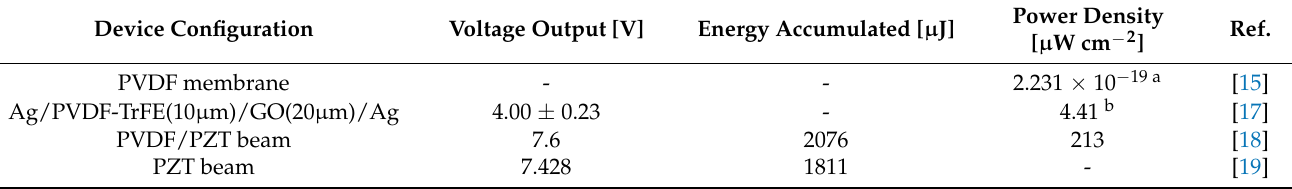
Table 1. Summary of selected electrical properties for piezoelectric devices.